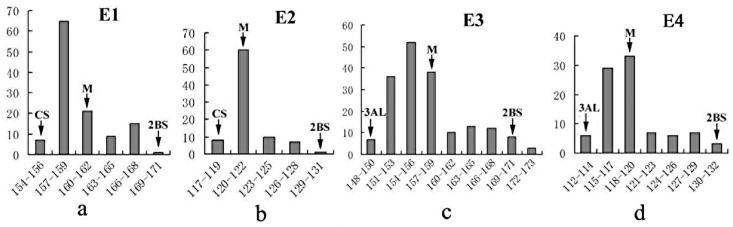
Distribution of heading dates in four wheat F2 populations.M: Middle value; CS: Chinese Spring; 2BS: CASL2BS; 3AL: CASL3AL; E1:CASL2BS×CS (Planting time: 11/10/2012); E2: CASL2BS×CS (Plant time:1/26/2013); E3: CASL3AL×CASL 2BS (Planting time: 11/10/2012); E4:CASL3AL×CASL 2BS (Planting time: 1/26/2013).